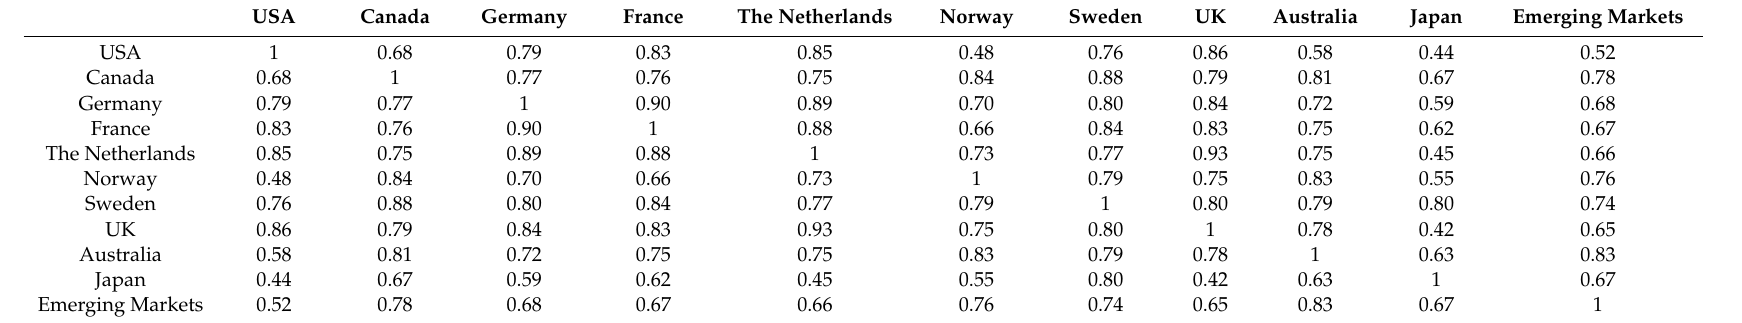
Table A2. The correlation matrix for the period